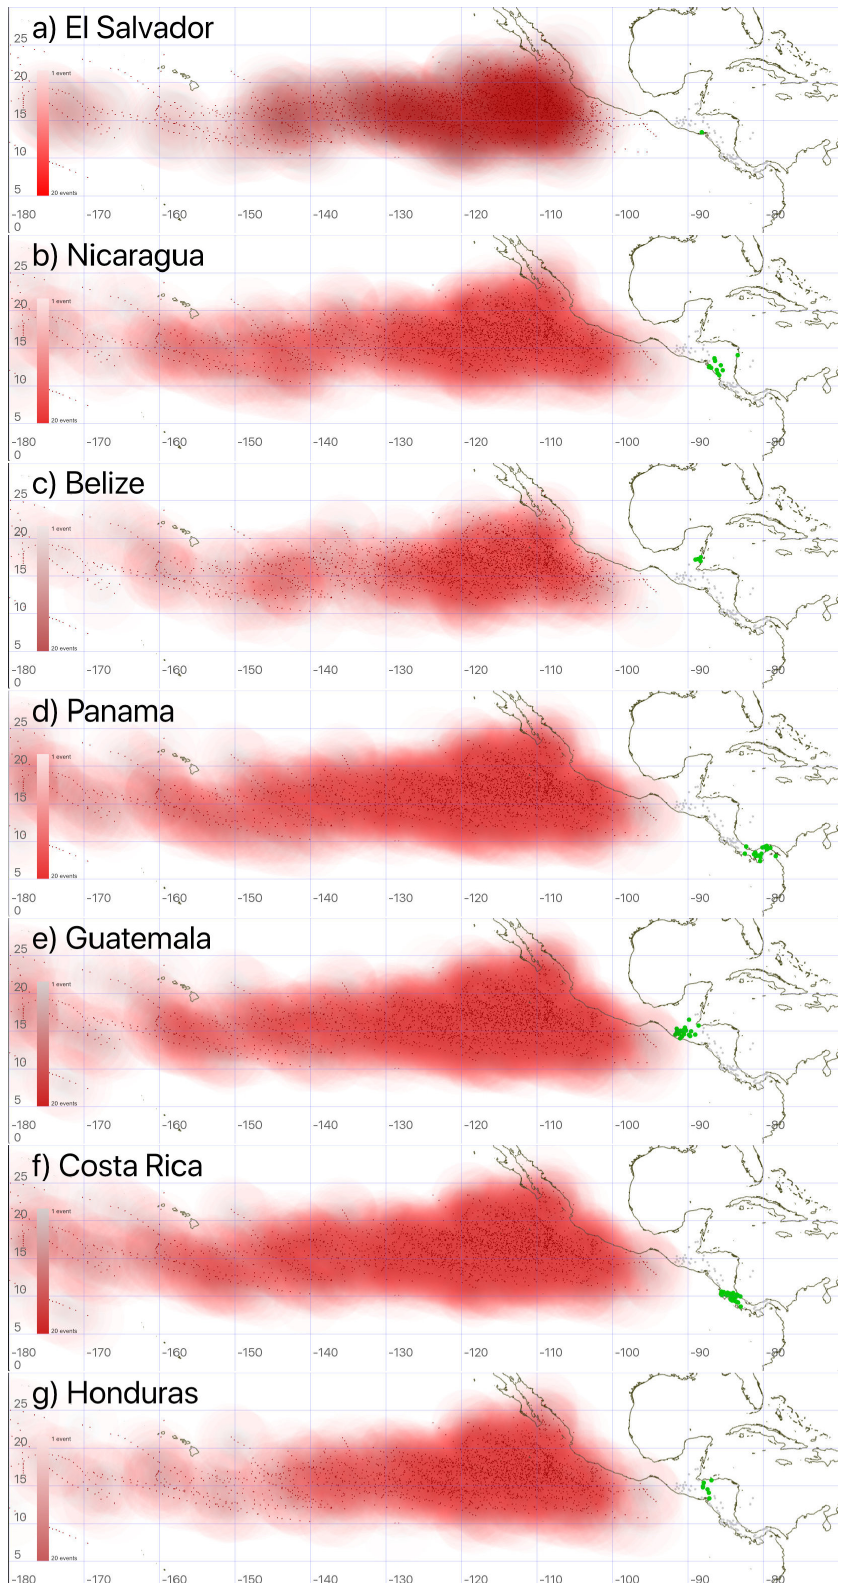
Figure 5. Same as Figure 1, but for cyclones in the Eastern Tropical Pacific basin. The subfigures are shown for El Salvador ( a ), Nicaragua ( b ), Belize ( c ), Panama ( d ), Guatemala ( e ), Costa Rica ( f ) and Honduras ( g